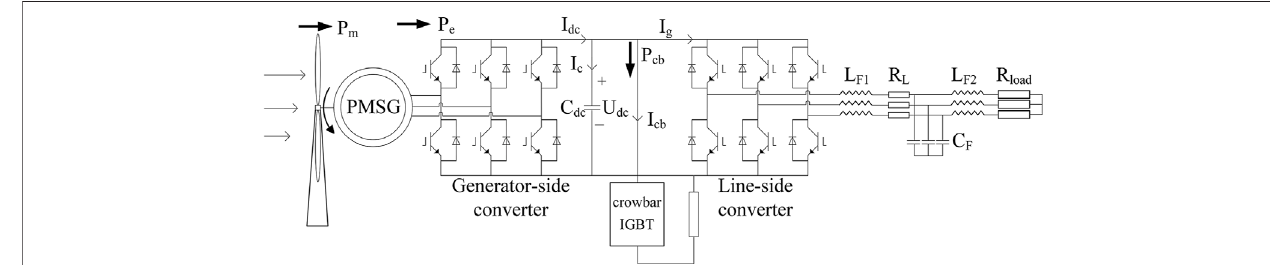
FIGURE 1 | Topology of the wind turbine during a black start.